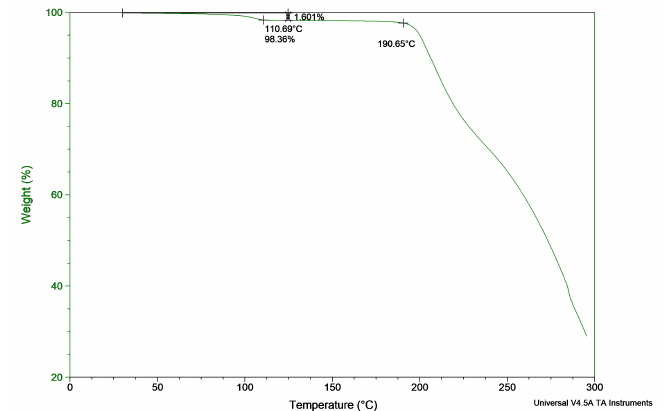
Figure 1. Thermogravimetric analysis (TGA) of zolpidem hemitartrate (ZHT) showing a weight loss of 1.6% at 110.69°C (loss of water) and a gradual weight decrease starting at 190.65°C.